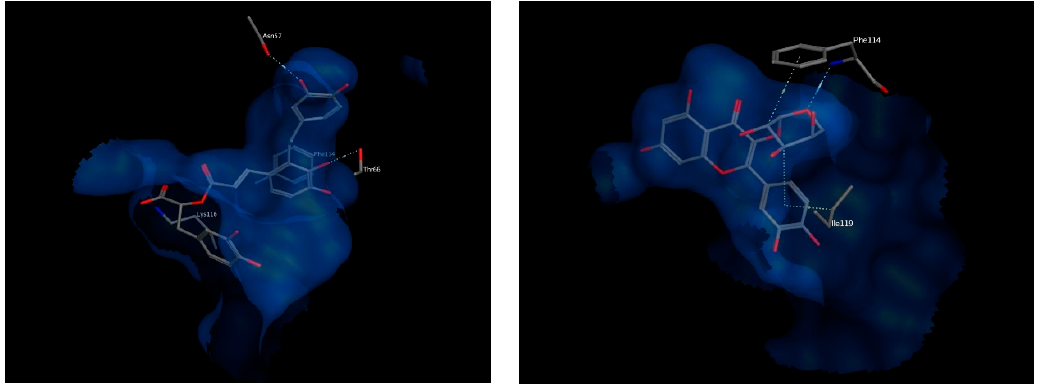
Figure 9. 3D view of interactions of Salvianolic acid A (left) as well as Quercetin pentoside (right) with amino acid residues of FLAP. Side chains of amino acids were omitted for clarity, except for Thr66 (right) and Phe114 (left), whose backbones participate in hydrogen bonding with the docked